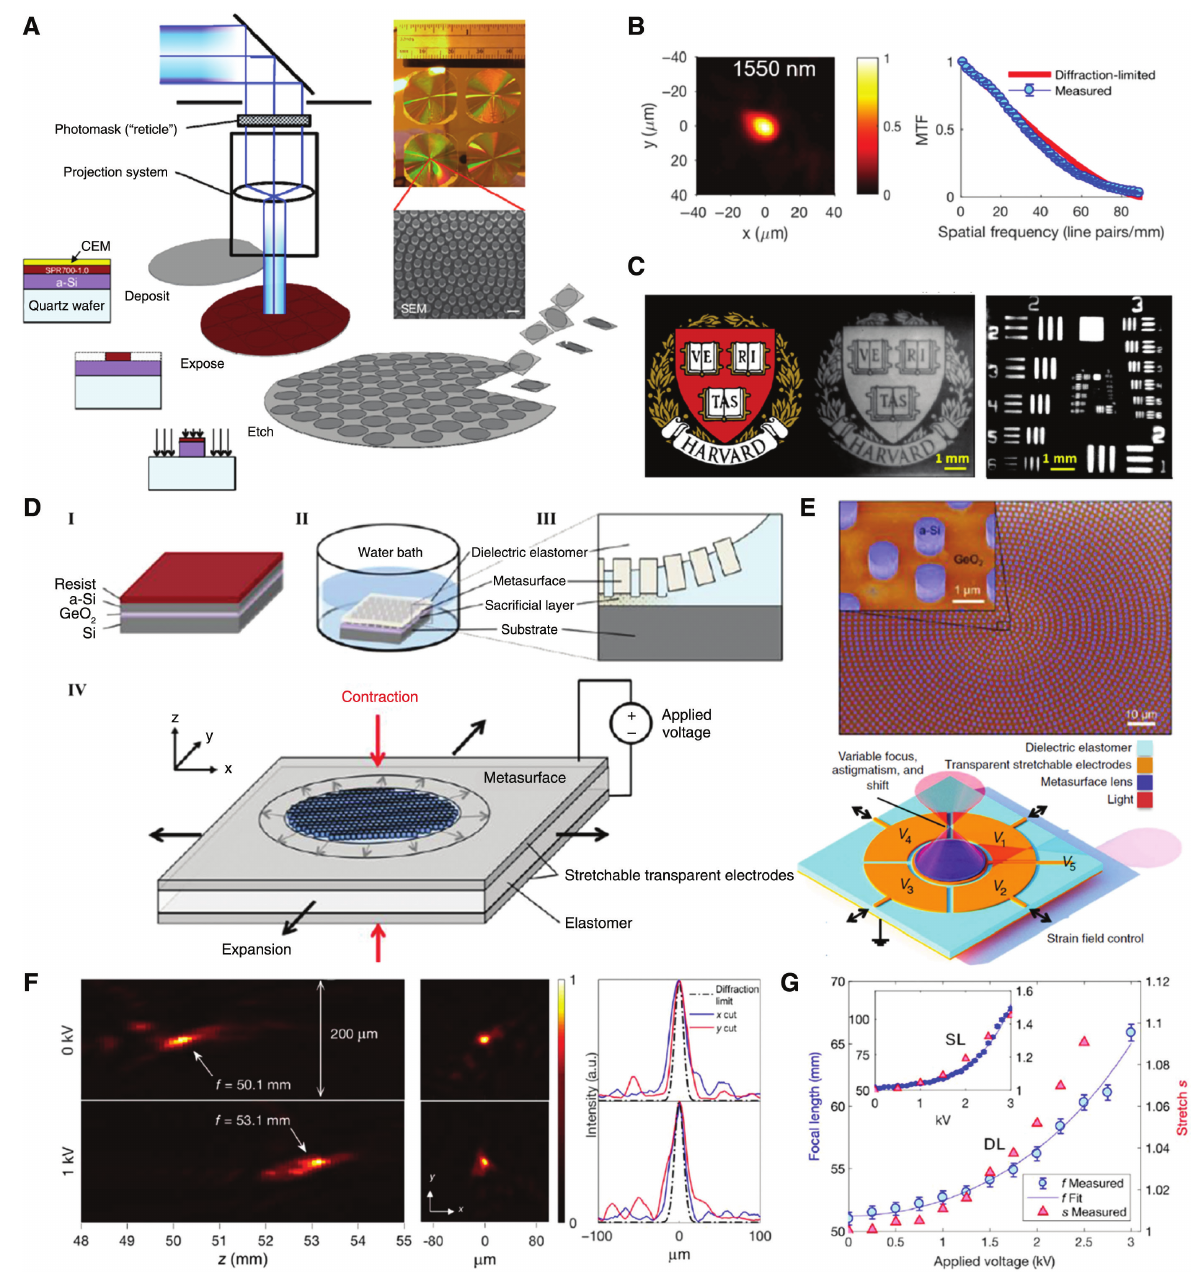
Figure 1: Metasurface-based devices working in near-IR patterned using a stepper with 365 nm light source. (A) Schematic of the fabrication process for large-area metalens working at 1550 nm, including a fabricated metalens and an SEM image of the patterned nanopillars at the metalens center. (B) Focal spot at 1550 nm (left) and plot of the measured MTF together with the theoretical diffraction-limited MTF for comparison (right). (C) Harvard logo and USAF 1951 resolution chart formed by the metalens at 1550 nm. (A–C) Adapted with permission from [73]. © The Optical Society. (D) Fabrication process flow for the adaptive metalens, including the layer transfer process on the elastomer layer using a sacrificial layer GeO . (E) False-colored SEM image of the patterned 2 nanopillars on GeO layer (top) and schematic of the functional adaptive metalens showing metasurface lens attached to the elastomer 2 and contacted through a stretchable electrode layer (bottom). (F) Focusing intensity along the z -direction under two different applied voltages (left), focusing spot intensity distribution at focal plane (middle), and intensity profile along the focal plane in compare with the theoretical diffraction-limited intensity profile (right). (G) Tuning of the focal length and stretch with respect to the applied voltage. (D–G) Adapted with permission from